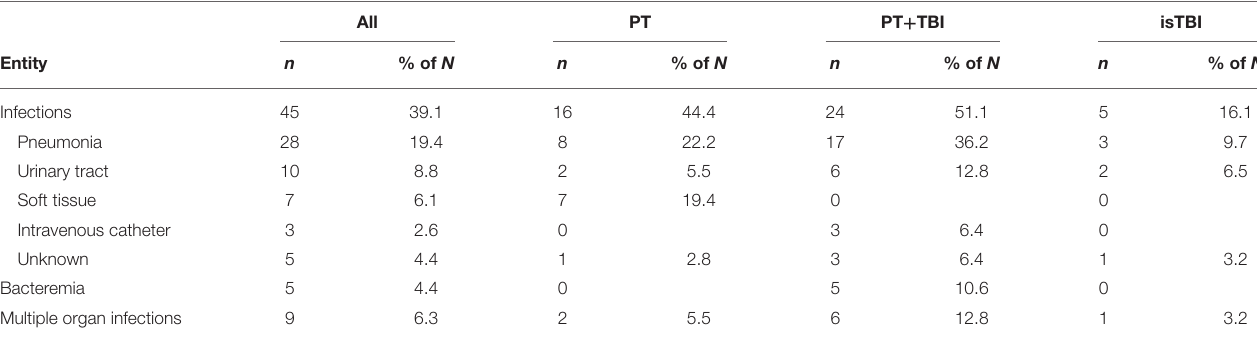
TABLE 2 | Post–traumatic infections in trauma patients stratified by injury